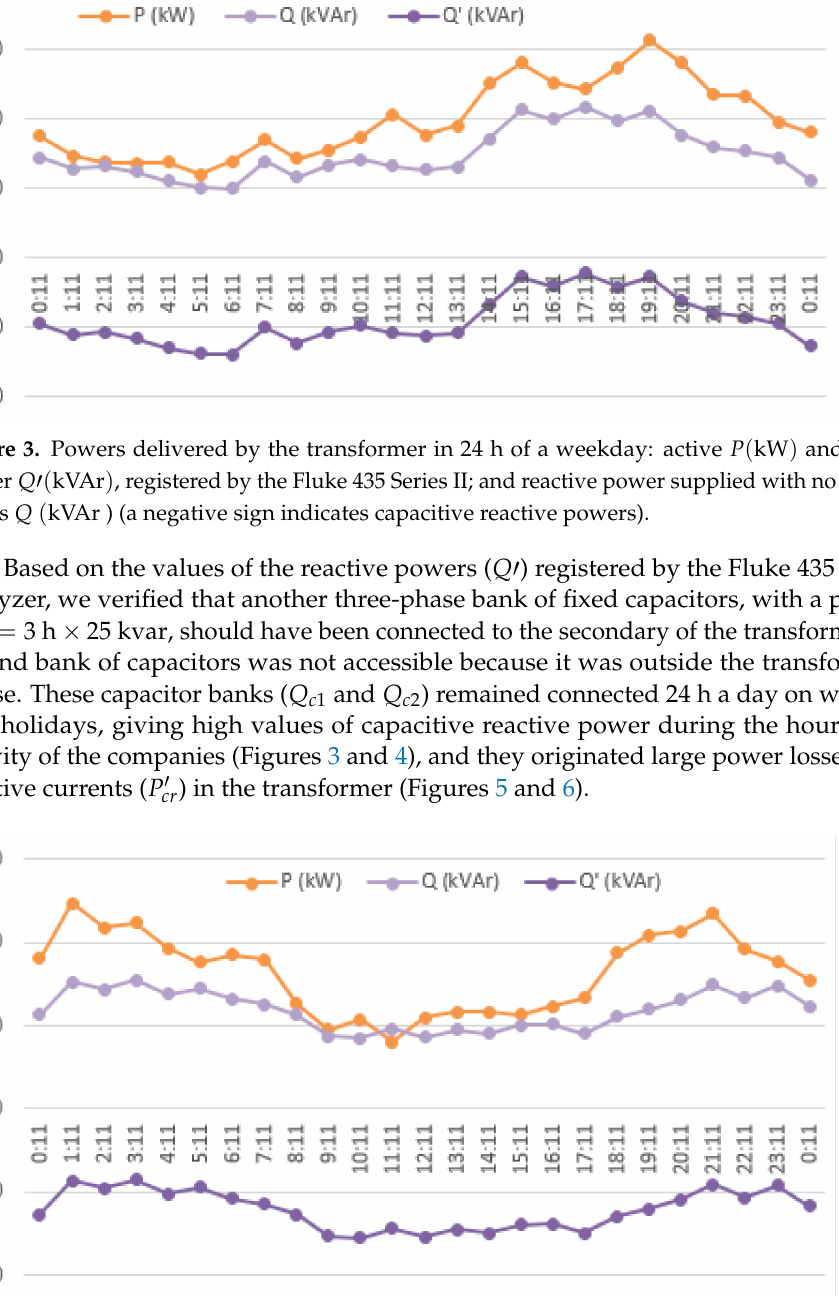
Figure 4. Powers delivered by the transformer in 24 h of a holiday: active P ( kW) and reactive Q (cid:48) ( kVAr ) powers registered by the Fluke 435 Series II; and reactive power supplied with no capacitor banks Q (kVAr) (a negative sign indicates capacitive reactive